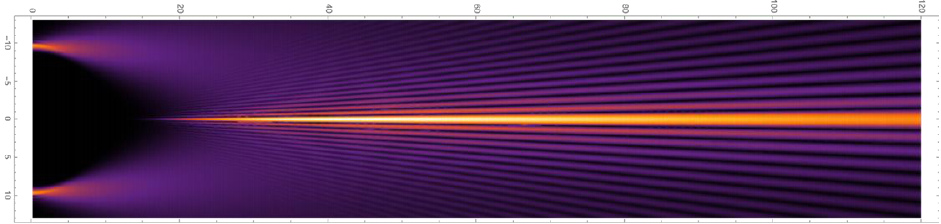
Figure 11. 5 MHz beampattern produced with only a single spherical Bessel function of integer order n = 199 and with imaginary offset parameter q = 1/2. The transducer is at the left and the axial range extends to 120 mm.